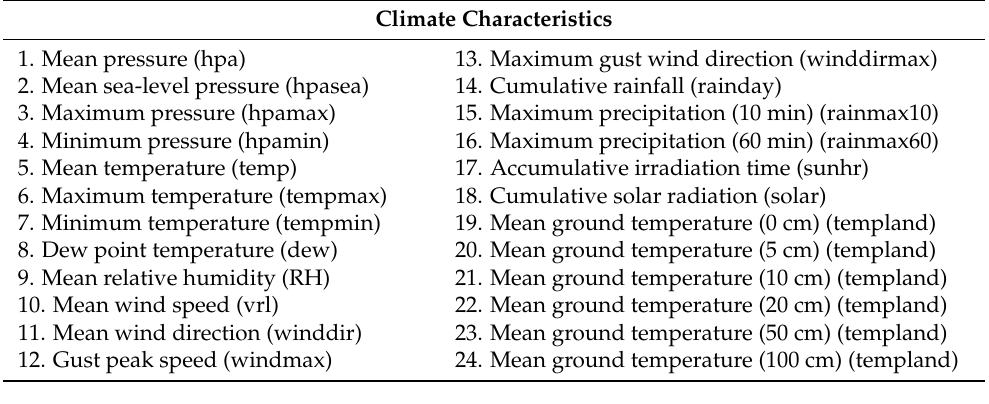
Table 1. Climate characteristics used in Experiment 1.